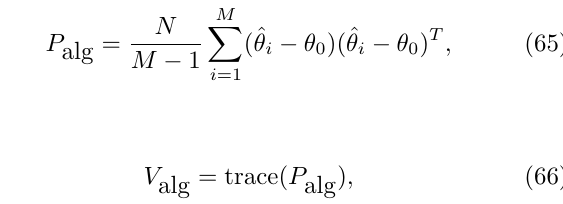
) = 1 and r k k ) = 2 . See k